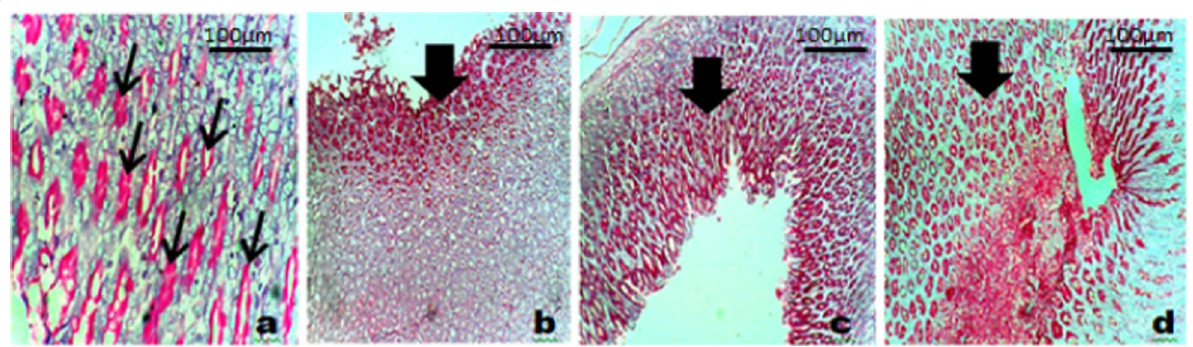
Fig. 11 Representative slides for evaluation of mucous cell density in the acetic acid induced stomach ulcer pretreated with folic acid and omeprazole. (PAS, X100). a Normal stomach. b Acetic acid stomach ulcer untreated. c Acetic acid stomach ulcer treated with Folic acid. d Acetic acid stomach ulcer treated with Omeprazole. Black (medium and large) arrow: Purple-red stained mucous cells